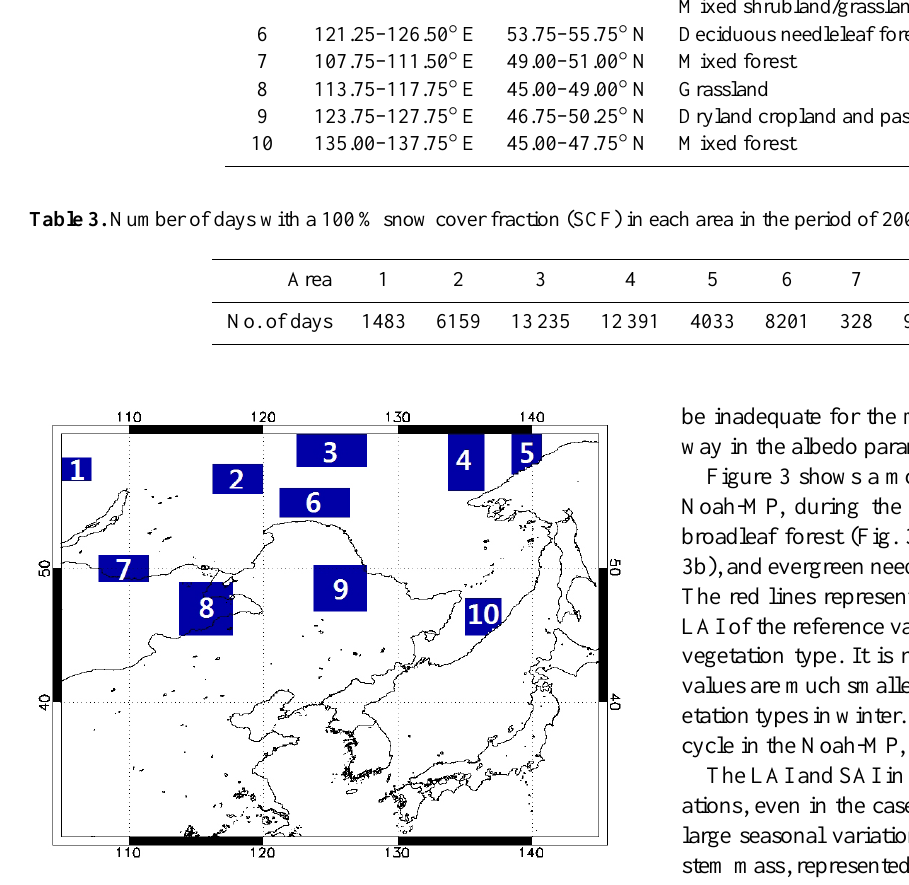
Figure 1. Geographical locations of the study domain. Each blue area has a dominant vegetation type as explained in Table